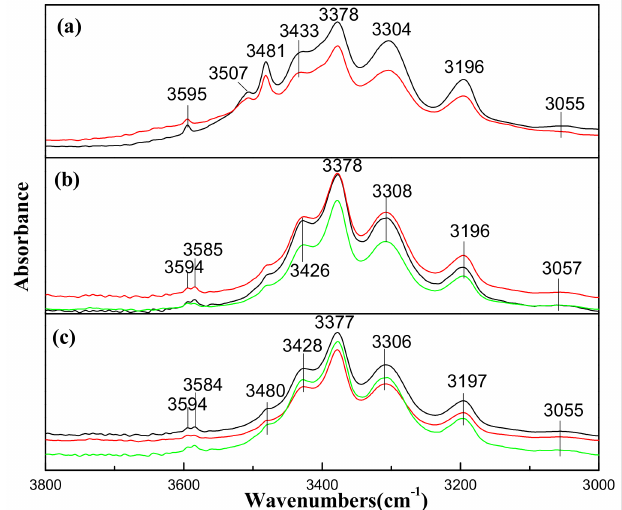
Figure 3. IR spectra of natural rock crystal samples (Group II) unheated and after heating at different temperatures. ( a ) IR spectra of unheated NQ − 7 and NQ − 10; ( b ) IR spectra of NQ − 1~NQ − 3 after heating at 673 K; ( c ) IR spectra of NQ − 4~NQ − 6 after heating at 1073